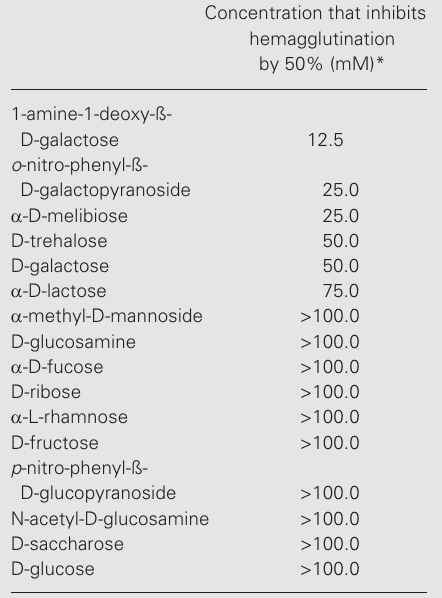
Table 3. Effect of saccharides on the agglutinating activity of cat liver galectin. Concentration that inhibits hemagglutination